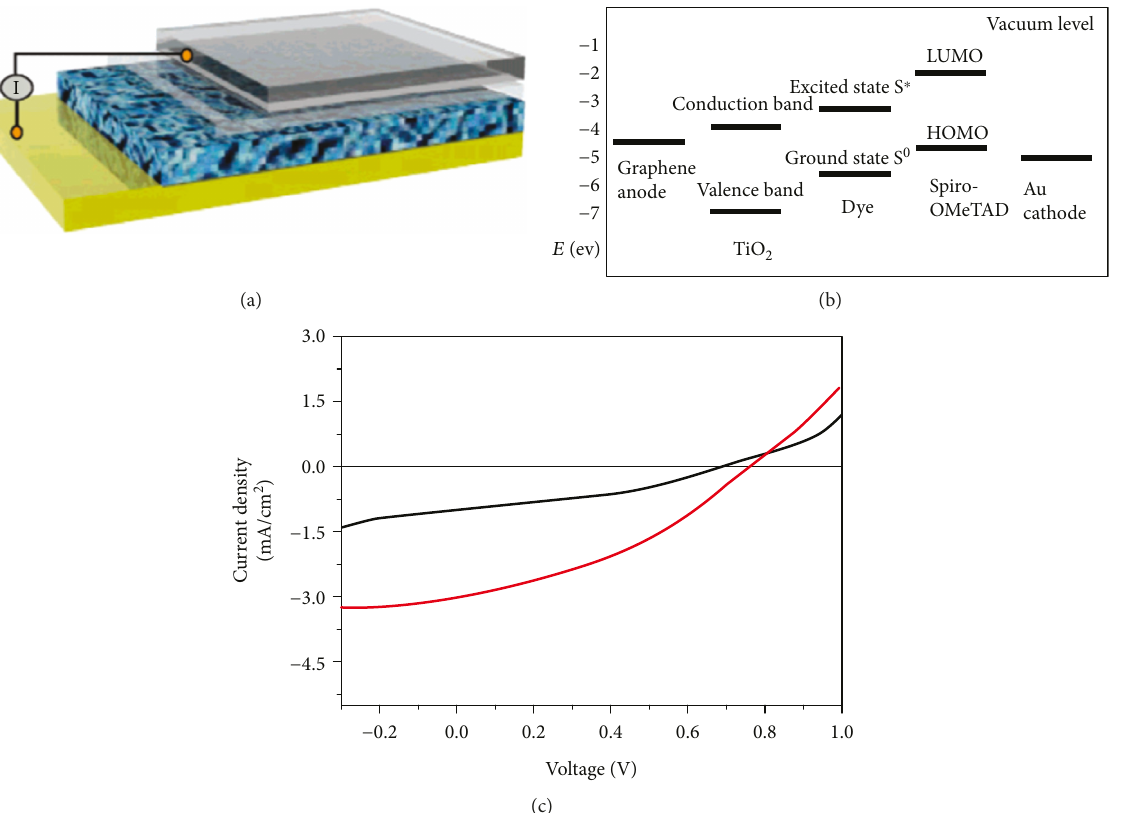
, and graphene fi lm. 2